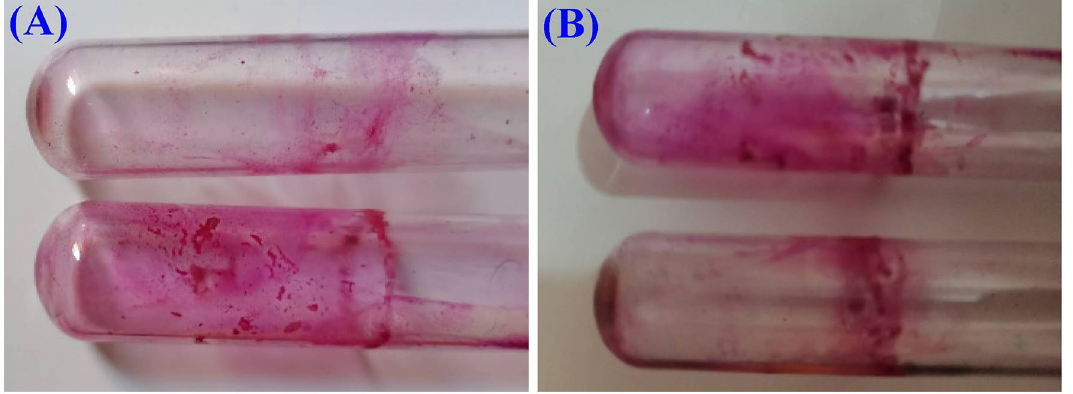
Figure 11. Evaluation of biofilm degradation ability of endoglucanase based on color intensity of the adherent safranin ring ( A ) P. aeruginosa biofilm treated and control ( B ) S. aureus biofilm treated and ual activity of 70.4% after being incubated for 90 min at 50 °C. The activity of endoglucanase greatly decreased on exposure to higher temperatures with a residual activity of only 12.43% when incubated for 90 min at 80 °C. Endoglucanase was shown to be more stable in alkaline pH (Fig. 10B). Kim et al . 91 reported similar findings for endoglucanase from Bacillus subtilis that was much stable at pH range 6–10. The heat inactivation half-life time (T 1/2 ) of the endoglucanase was determined at the employed temperatures and heat deactivation constant (k d ), the linear regression of the measured values was produced by fitting the data points to first order equation that is according to Eq. (4) and their values were provided in Table 9. The half-life time (T 1/2 ) of endoglucanase was reported to be 139.53 min at 50 °C and 82.67 min at 60 °C. However, the devastation of endoglucanase enzyme was observed at 80 °C with short half-life time (49.42 min).